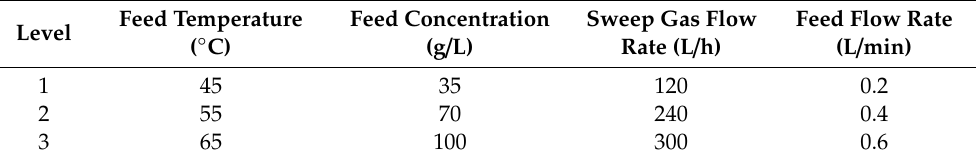
Table 1. Factors and their levels in the experimental design.